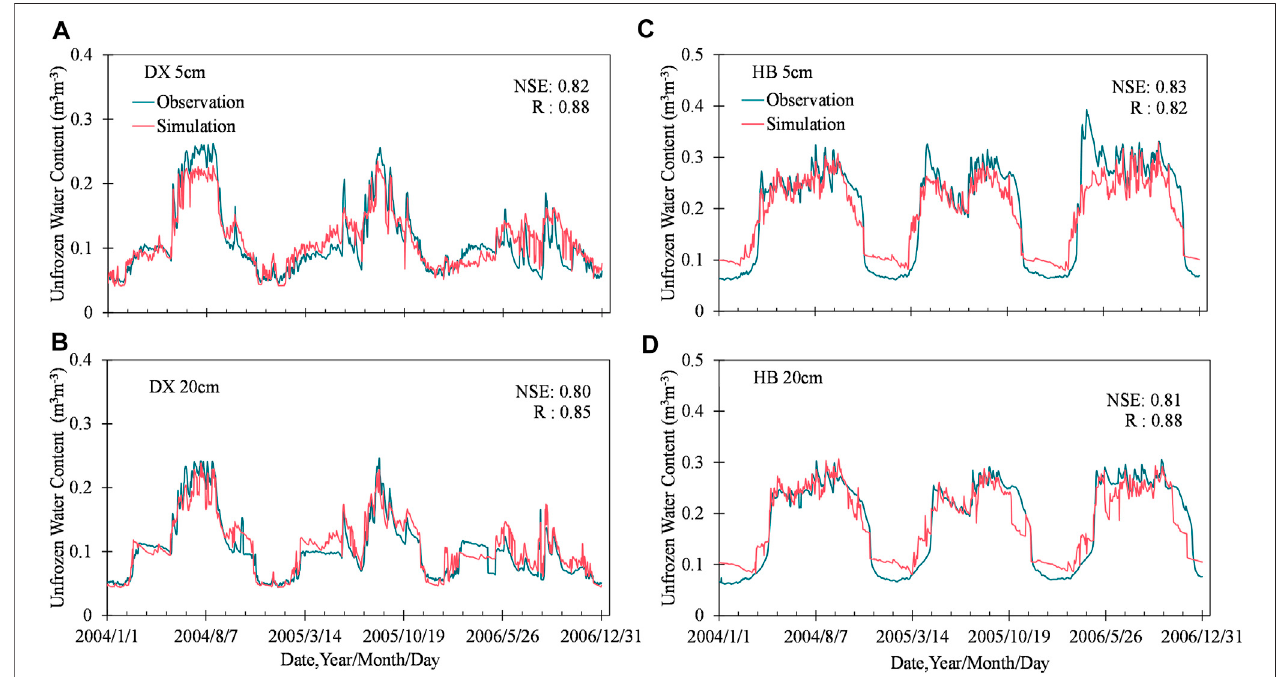
FIGURE3| SimulatedandobservedunfrozenwatercontentatdifferentdepthsatDamxung[DX, (A,B) ]andHaibei[HB, (C,D) ]sites.NSE:Nash-Sutcliffeef fi ciency coef fi cient; R: Pearson ’ s correlation coef fi cient.